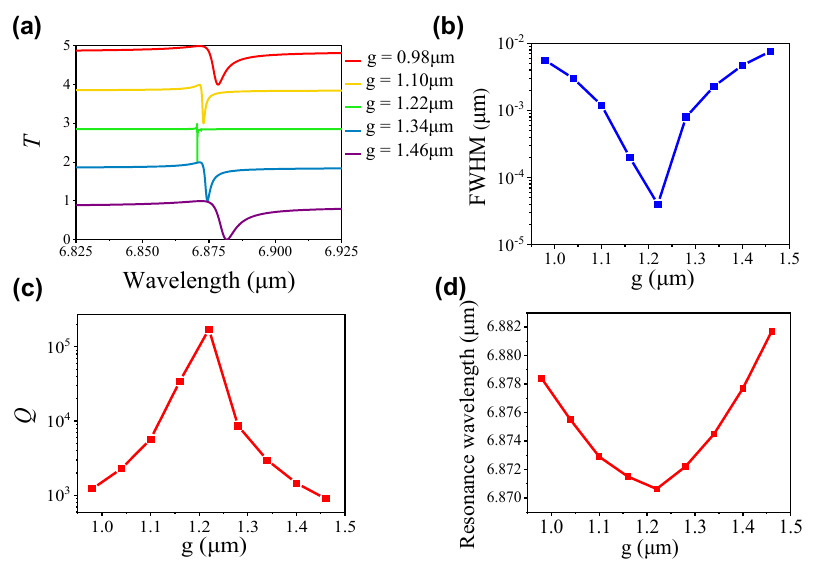
Figure 2: Simulated transmission spectra of the symmetric metasurface. (a) The trans- mission spectra. (b), (c) and (d) are FWHM, Q-factor, and resonance wavelength under different gap distance g between adjacent square disks, respectively.